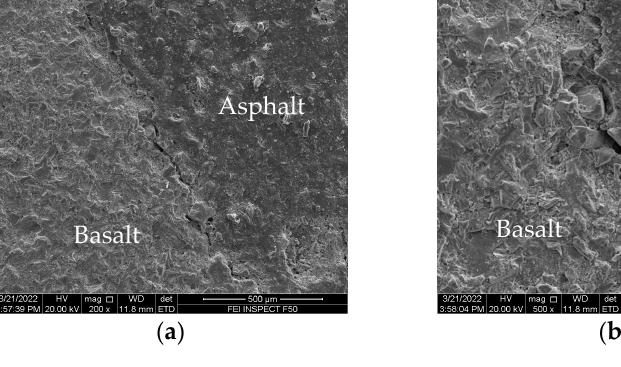
Figure 11. Asphalt-binder and basalt interfacial imaging results: ( a ) × 200 Magnification;